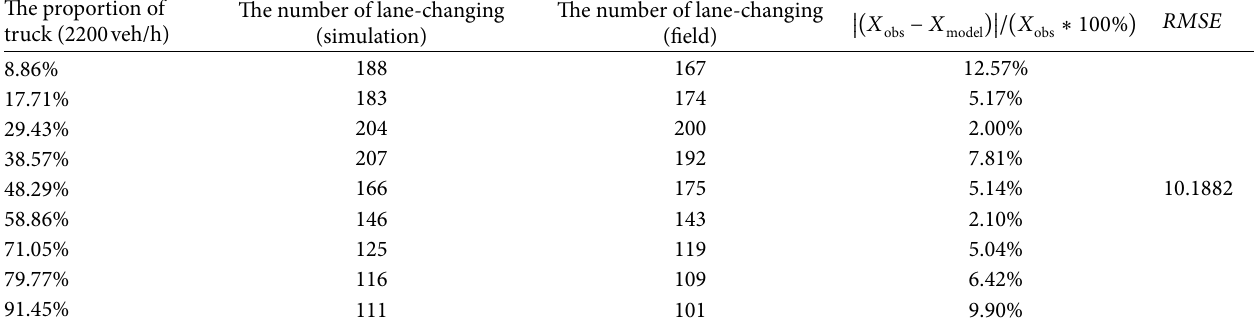
Table 5: The estimation of